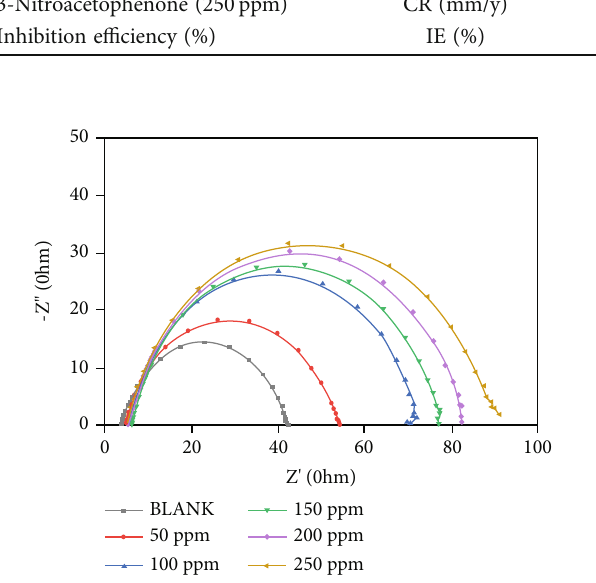
Figure 3: Nyquist plot for MS obtained with the absence and presence of 50-250 ppm of 3-NA in 1N HCl.